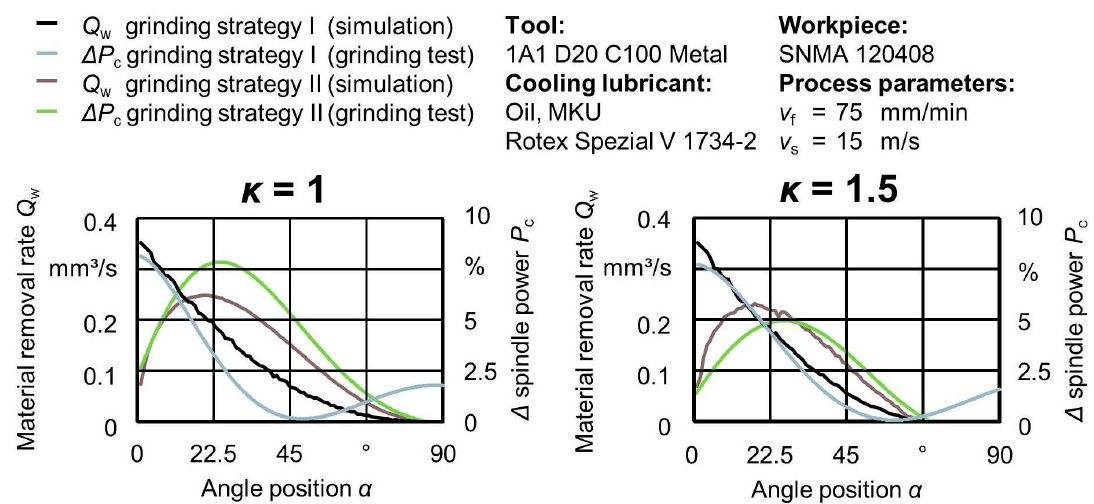
Figure 9. Comparison of curve progressions of simulation data and spindle power data.